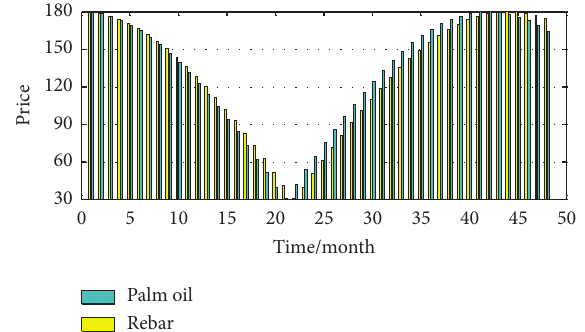
Figure 6: GARCH fitting parameter diagram of rebar price change